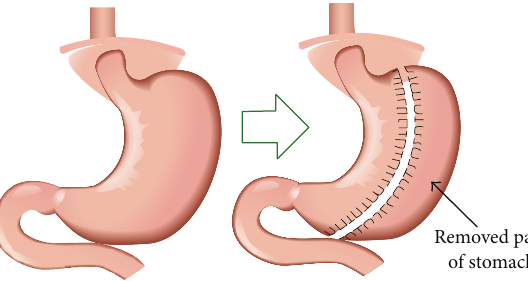
Figure 1: Schematic diagram of sleeve